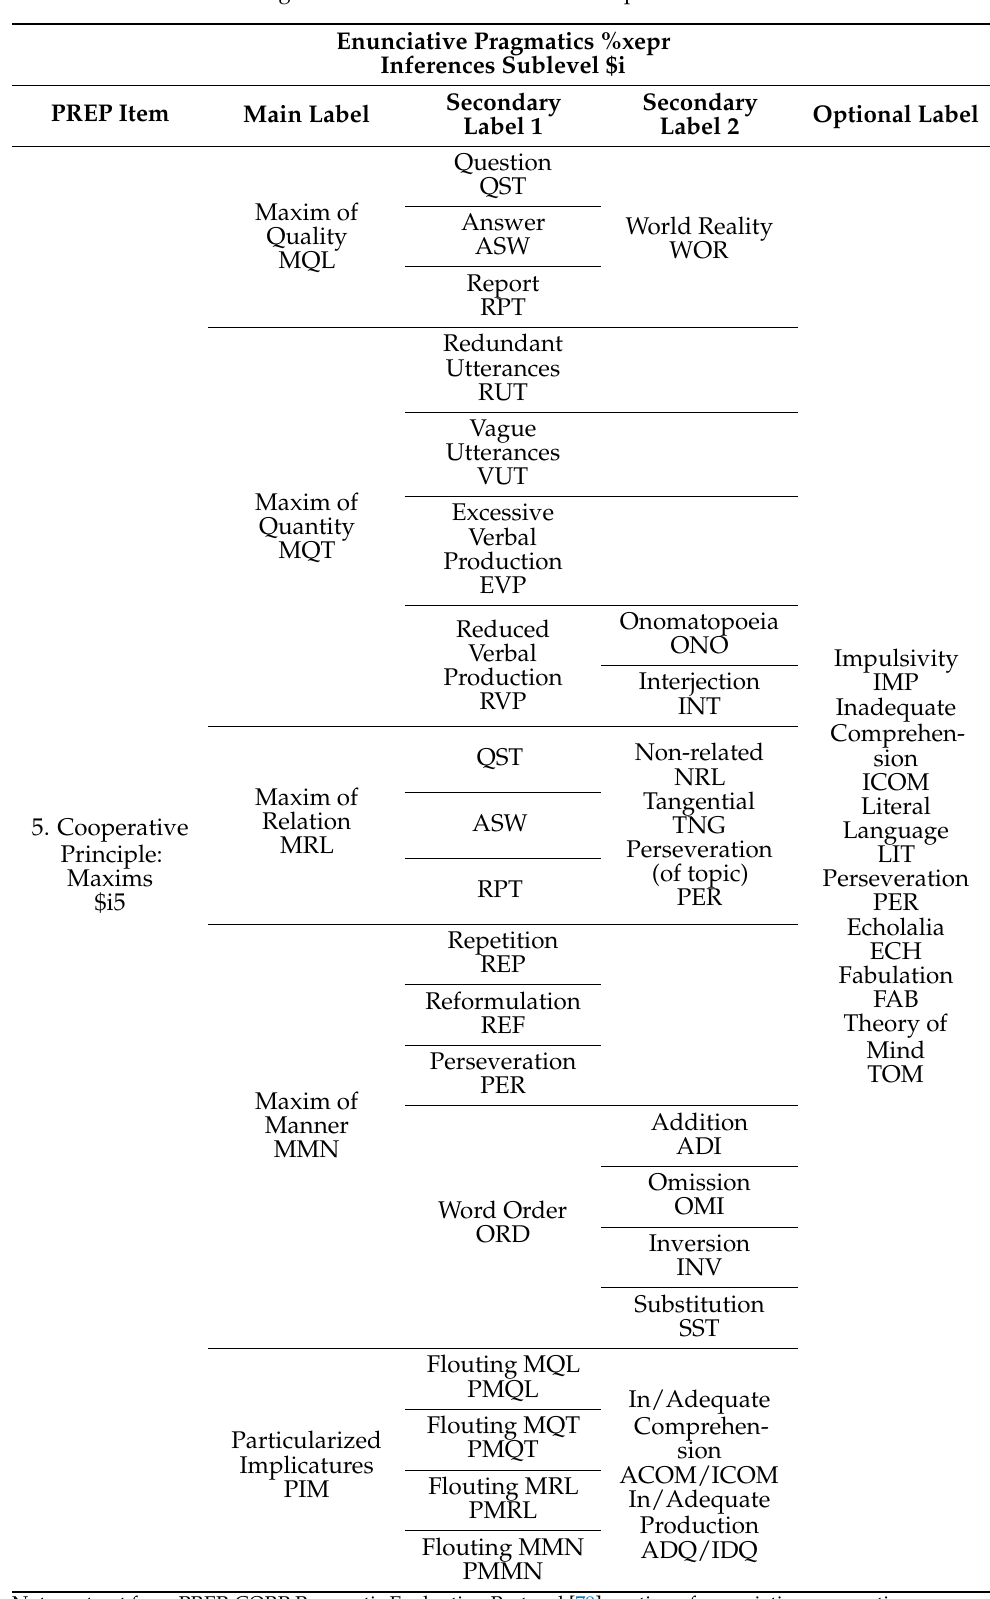
Table A1. PREP-CORP Pragmatic Evaluation Protocol for